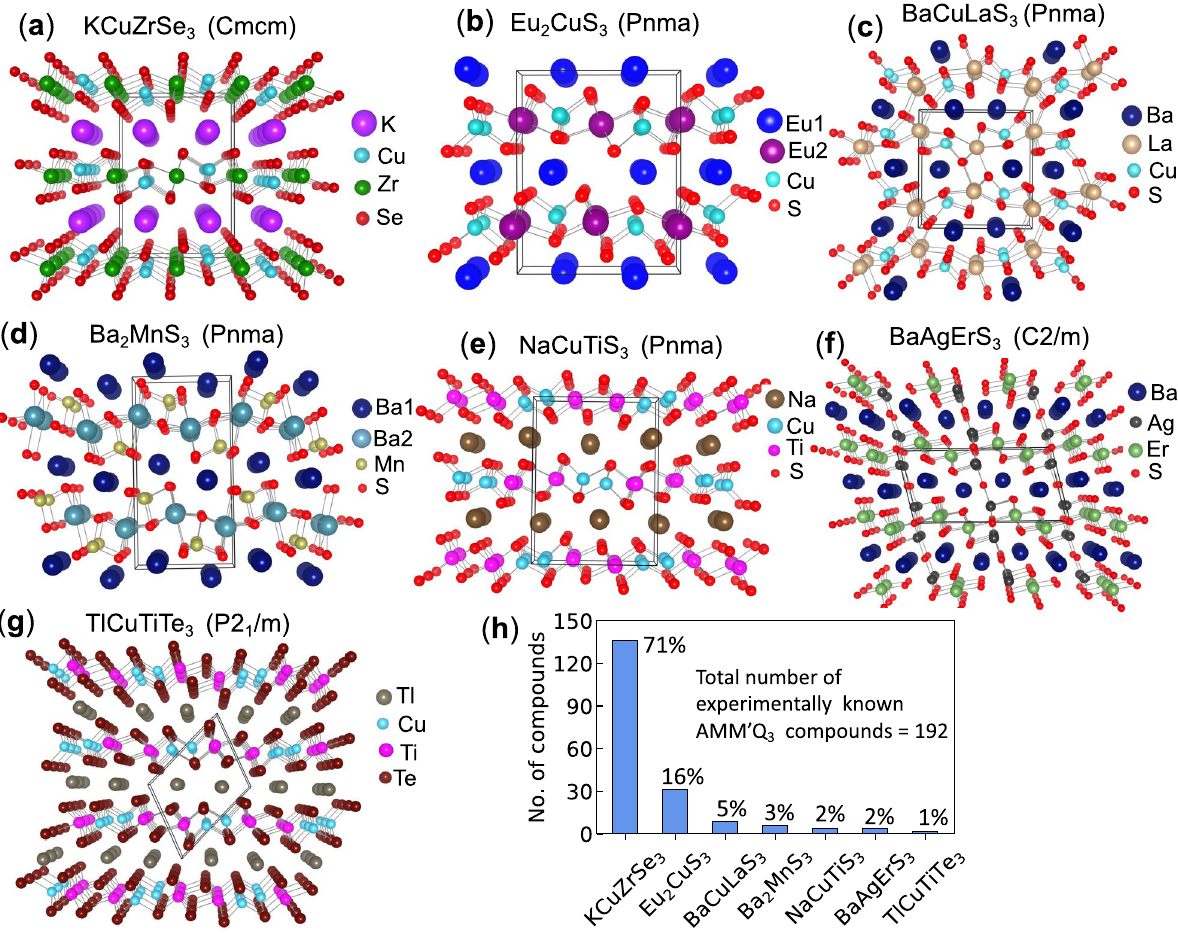
Fig. 1 Crystallographic prototypes of the AMM ′ Q 3 compounds. a – g Seven structural prototypes in the family of experimentally known AMM ′ Q m + cations are sandwiched between the covalently bonded 3 compounds. Most of them have layered crystal structures where the layers of A layers of [MM ′ Q 3 ] m − anion sublattice, and interact with the later through electrostatic interactions. The black solid lines in each fi gure indicate the conventional unit cell of each compound. h Distributions of the experimentally known AMM ′ Q 3 compounds in the seven structure